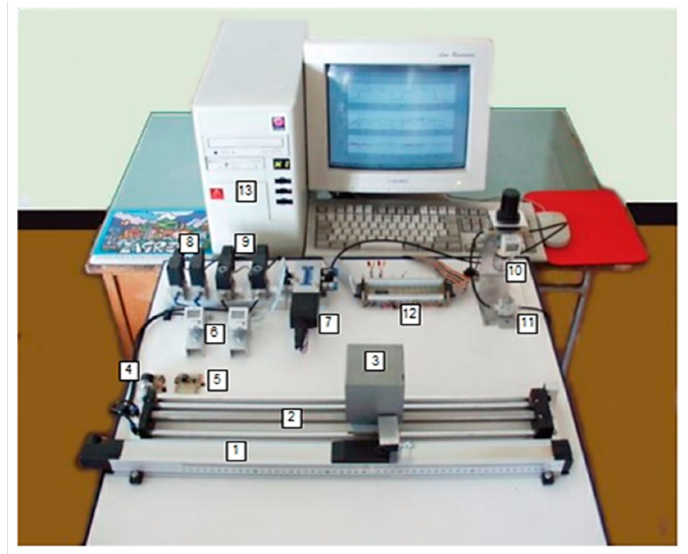
Figure 1. Photo of the experimental